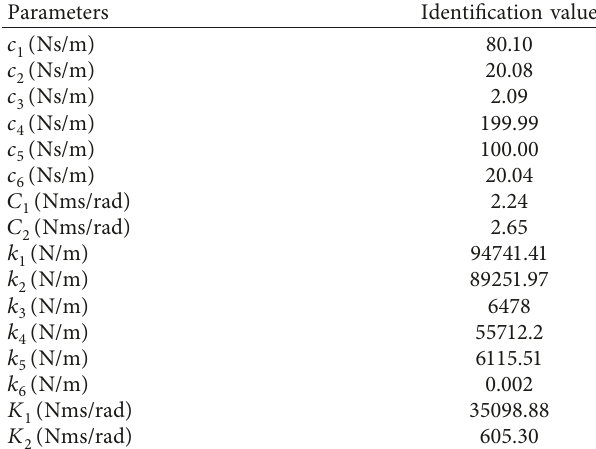
Table 3: The parameter identification